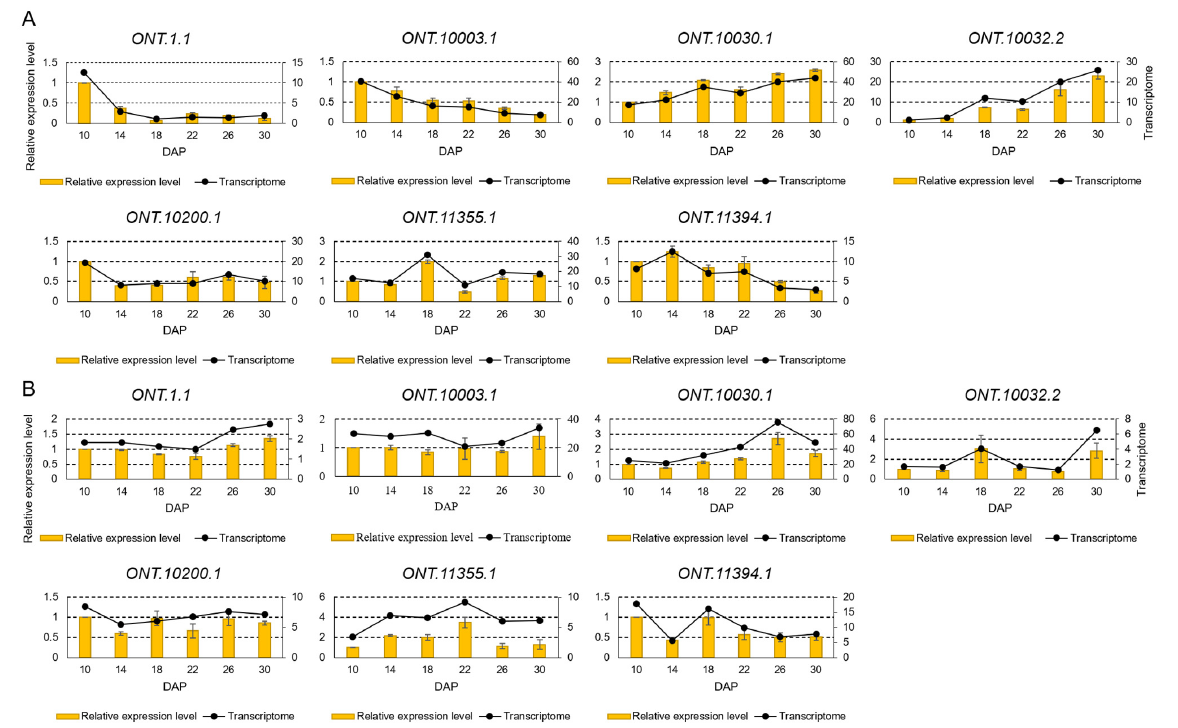
Figure 2. Validation of expression levels of seven randomly selected DEGs in developing kernels of Xuetian 7401 and Zhetian 11. Gene expression levels determined by qRT-PCR are represented by a column and RNA-Seqs are represented by a line. ( A ) Xuetian 7401; ( B ) Zhetian 11. The data of the qRT-PCR are mean ± SE. Table 2. Statistical table of the DEG numbers of developing